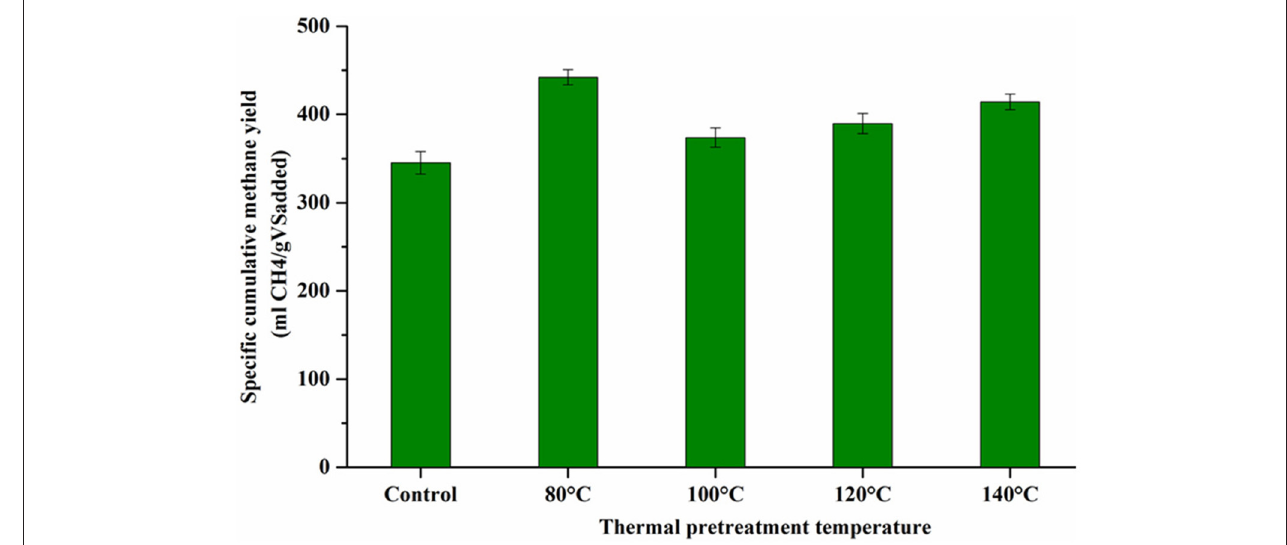
FIGURE 4 | Specific cumulative methane yields for the untreated and thermally pretreated FW.